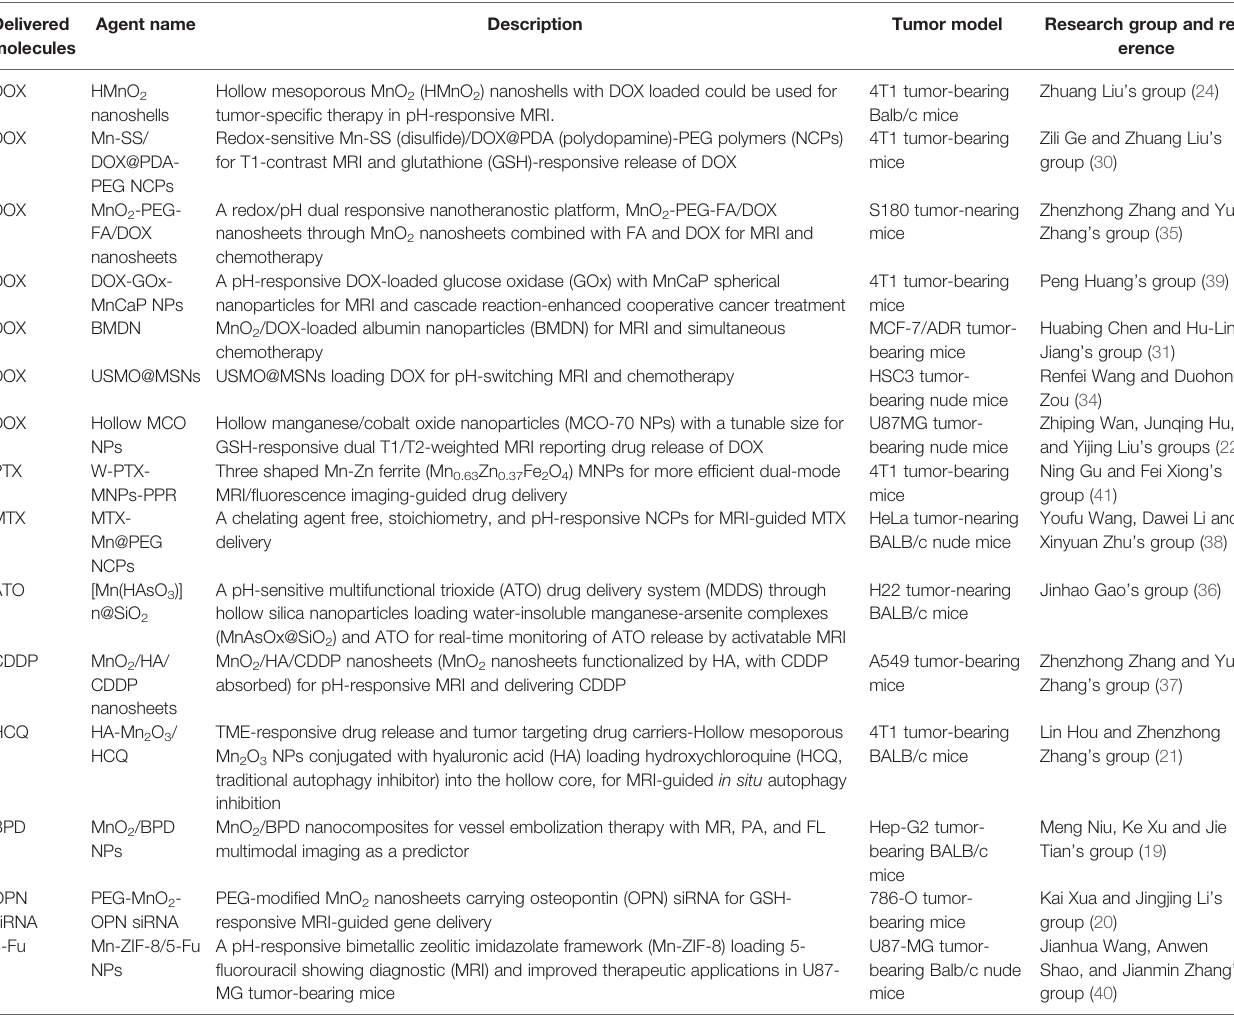
TABLE 2 | Manganese-based hybrid nanomaterials as carriers for drug delivery. Delivered Agent molecules